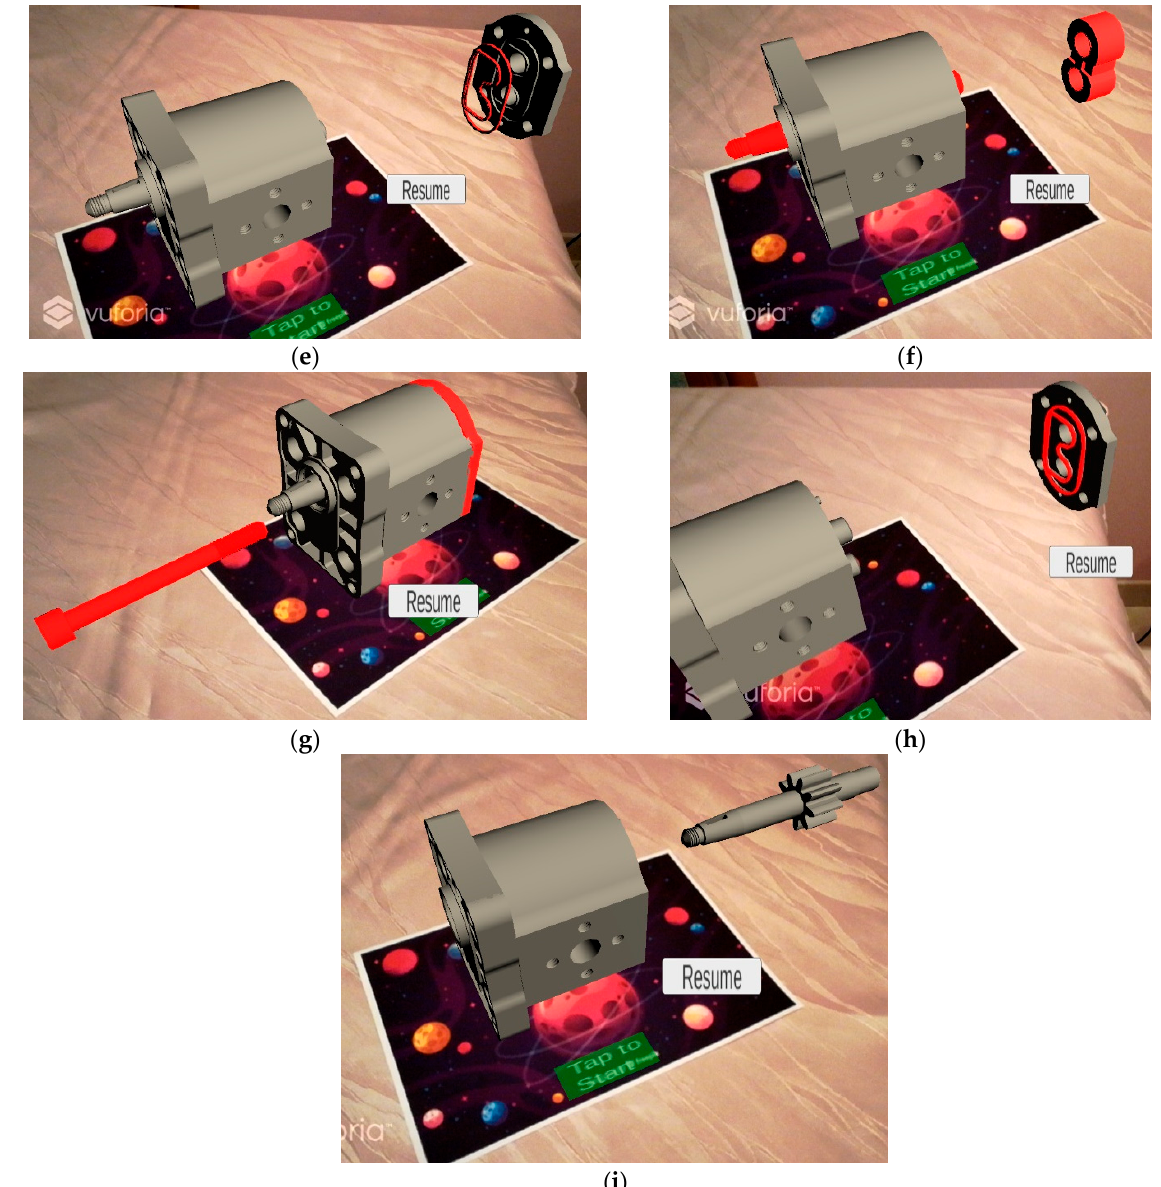
Figure 19. Views of the application in AR on the Android application: ( a ) view from the side of the gear pump; ( b ) front view of the gear pump; ( c – i ) different steps of the disassembly sequence captured with the animation paused by the UI button Pause/Resume.